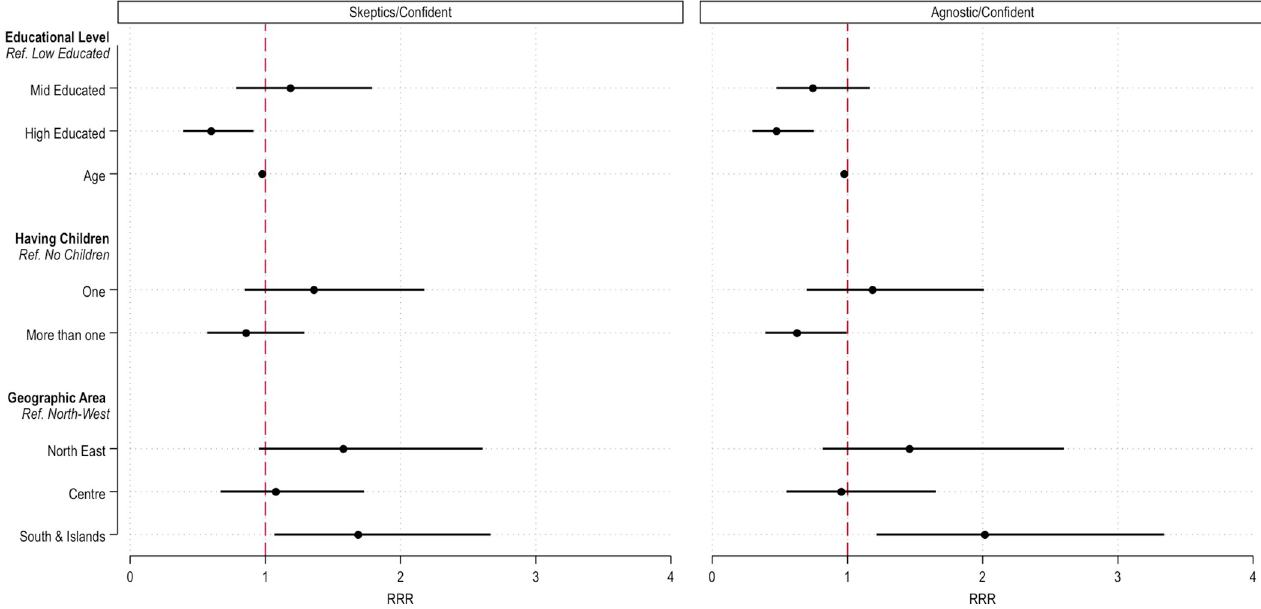
Fig 3. Multinomial logistic regression predicting the probability to belong to each RCA group as a function of individuals’ sociodemographic characteristics. Predictor variables include: educational level, age, gender, whether respondents have children, religious affiliation, geographic area of residence and rural or urban area of residence. Relative Risk Rations, 95% CIs, weighted